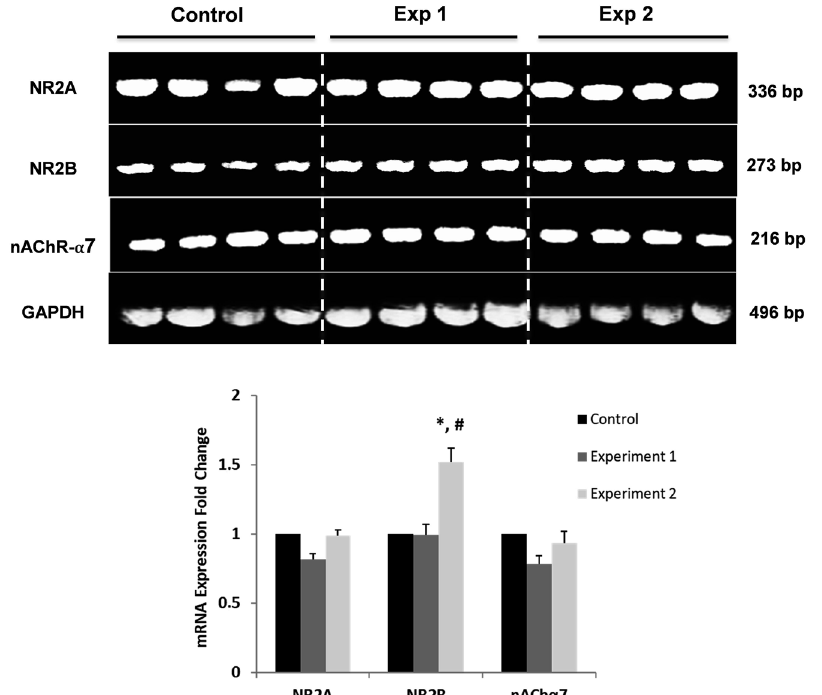
Figure 3: Representative images of mRNA expressions of NR2A, NR2B, and nACh α 7 receptors and comparison of results between groups. *Indicates a signi fi cant di ff erence compared to the CG (p<0.05); # indicates a signi fi cant di ff erence compared to the Exp1G (p<0.05); CG, control group; Exp1G, experiment 1 group. Data are given as mean ±